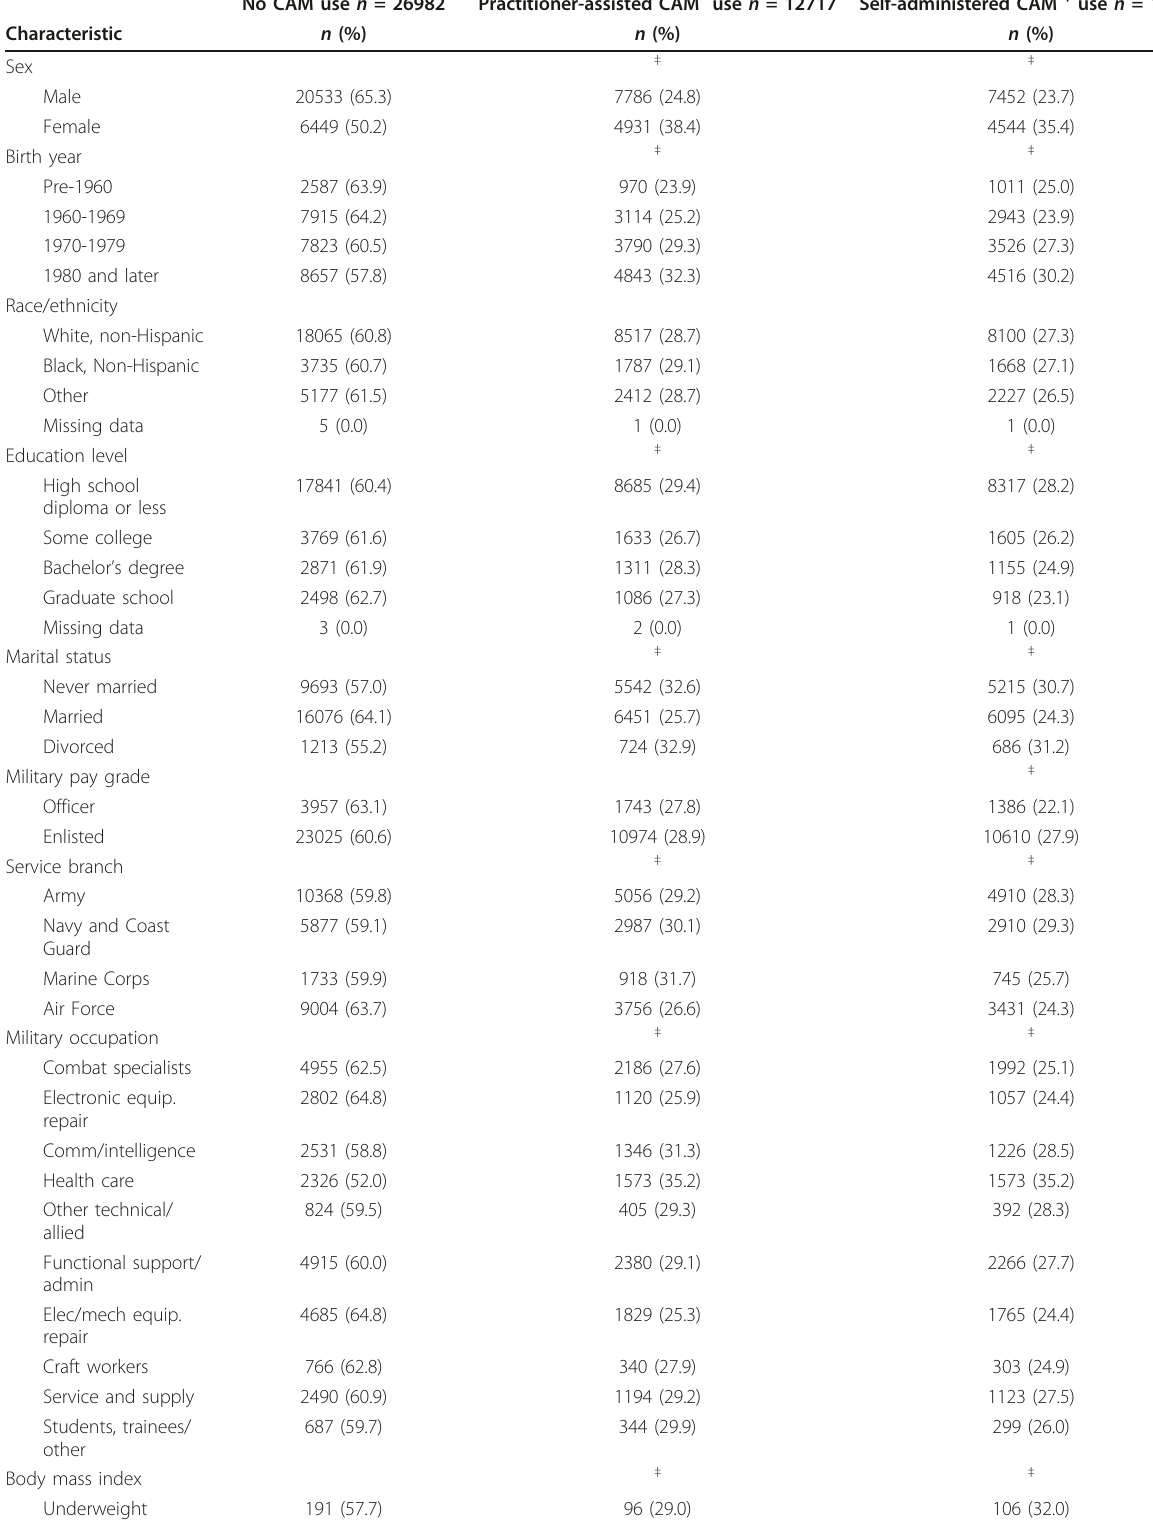
Table 1 Demographic and military characteristics of 2004-2006 active-duty Millennium Cohort participants by complementary and alternative medicine use ( N =